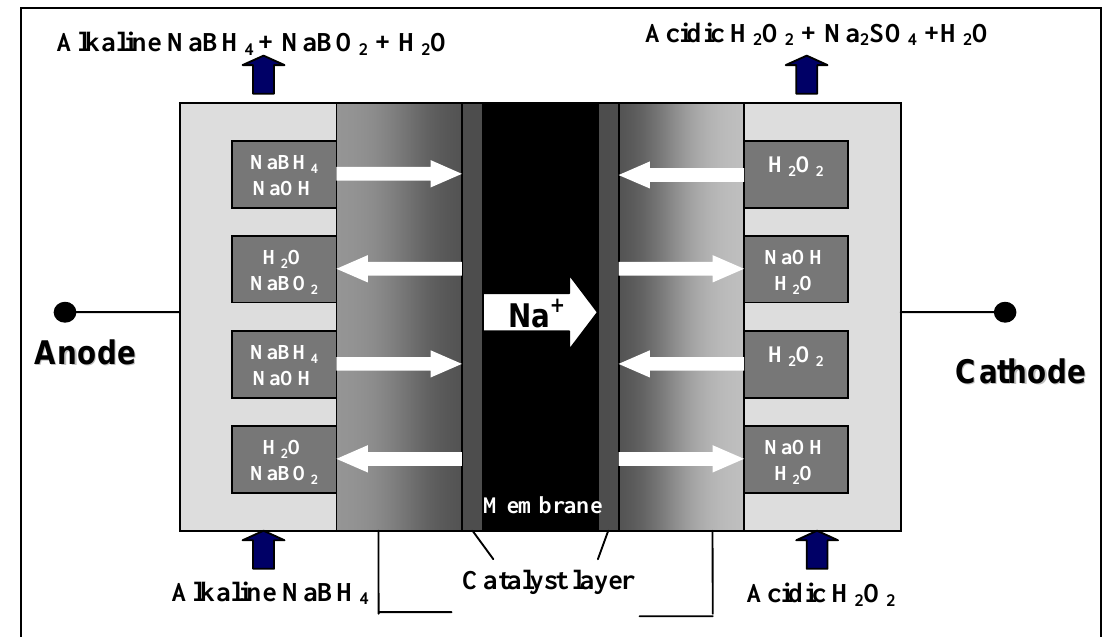
Figure 1. Operating principle of the